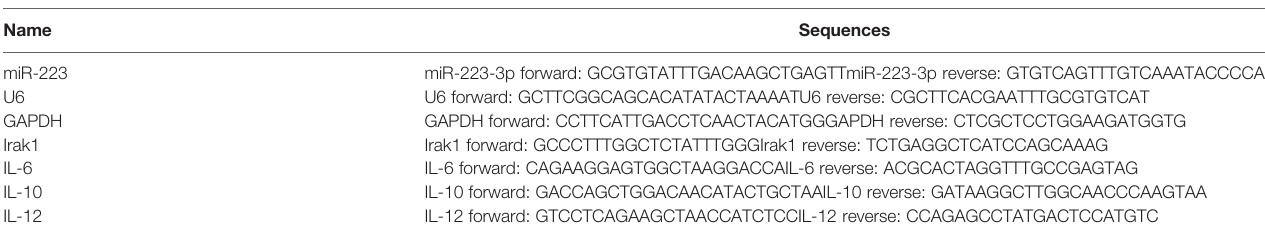
TABLE 1 | Primer sequences used for